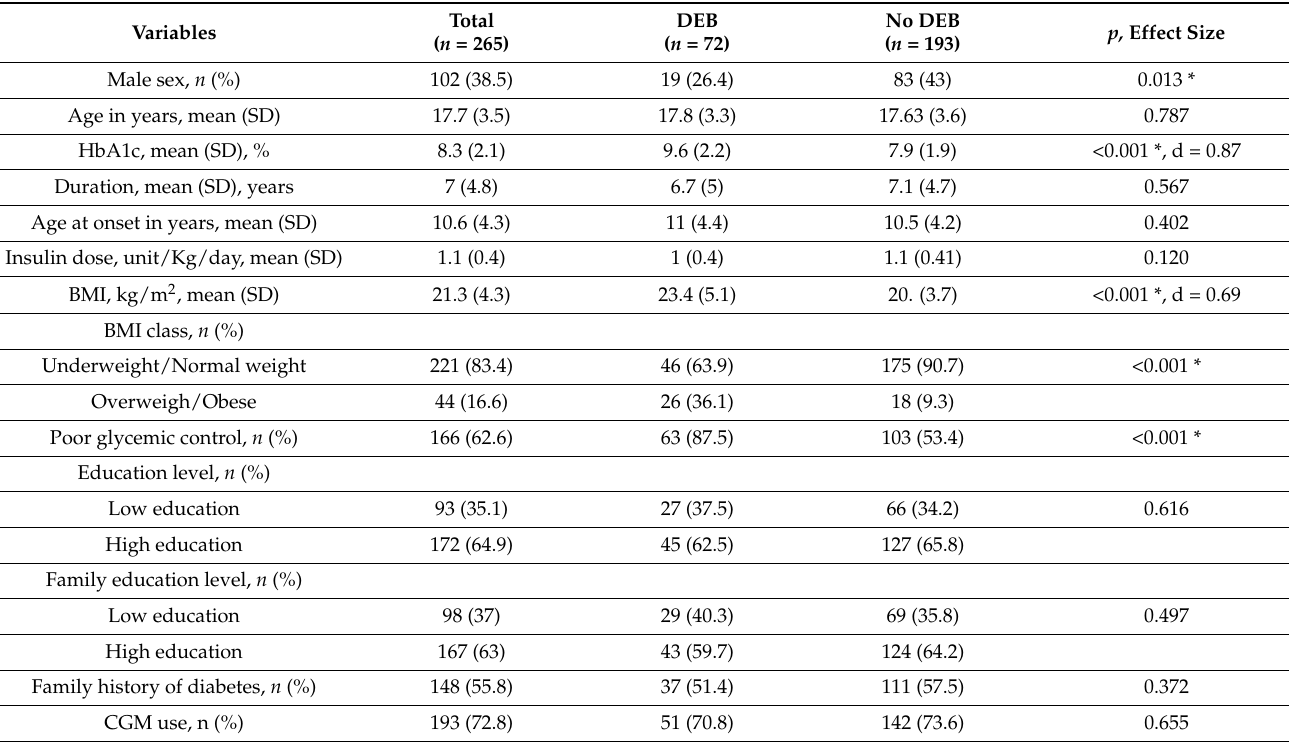
Table 2. Comparison of participants with and without